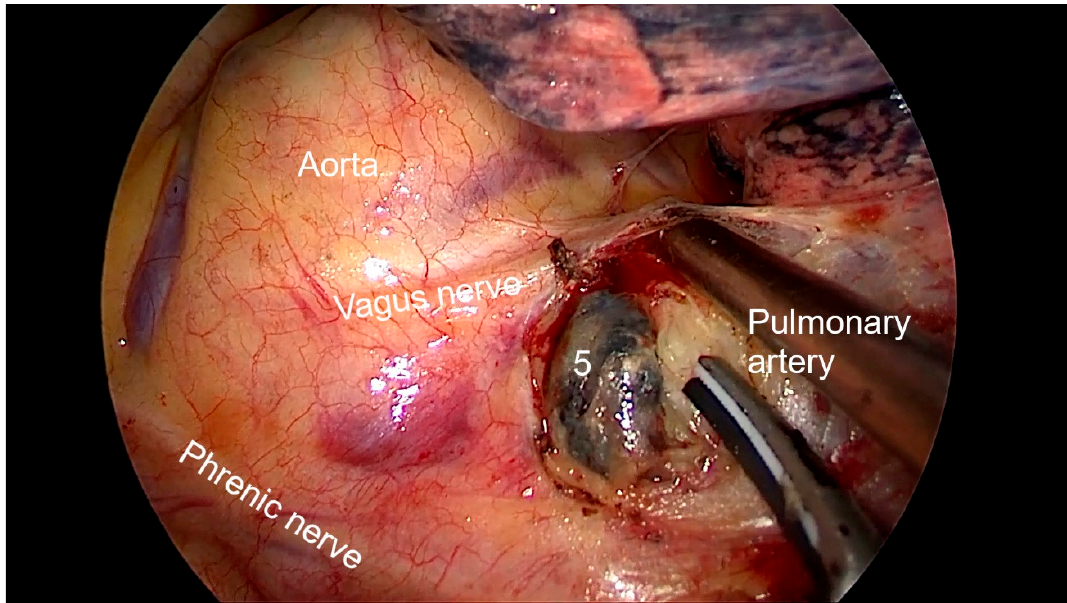
Figure 10. Anatomic landmarks during left aortopulmonary window (5) and paraaortic (6) lymph node dissection.